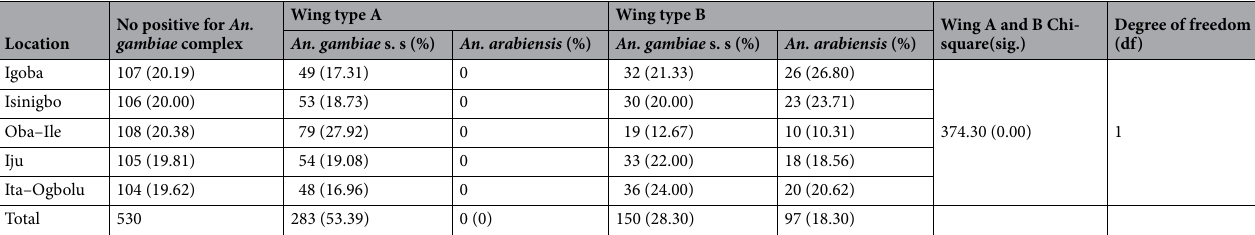
Table 2. Variation in wing types among Anopheles gambiae complex collected in the study area. χ 2 = 24.39; df = 4; P = 0.02 (P < 0.05). Wing type A: Wing with a pale interruption proceed with the sub-coastal pale spot. Wing type B: Wing with a pale interruption found within the pre-apical dark